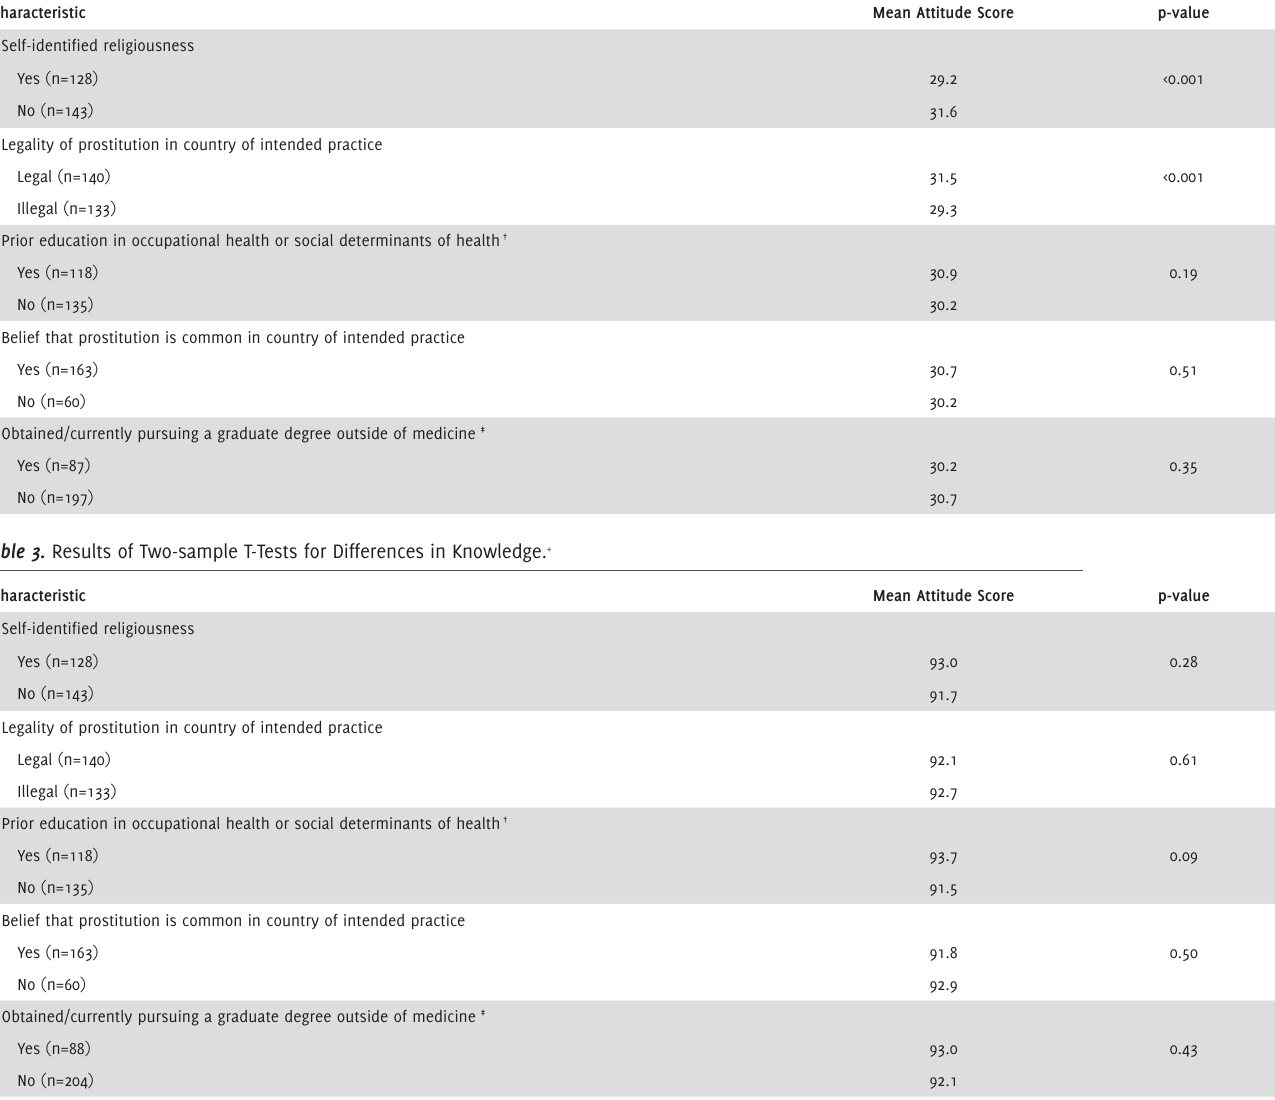
Legend (For Table 2 and 3): + Data for participants who selected “uncertain” or “decline to answer” were excluded from analysis. † Of all participating students, 40.4% (n=118) had previous education in social determinants of health or occupational health, 46.2% (n=135) did not, and 9.2% (n=27) were uncertain. ‡ Of all participating students, 30.1% (n=88) had completed or